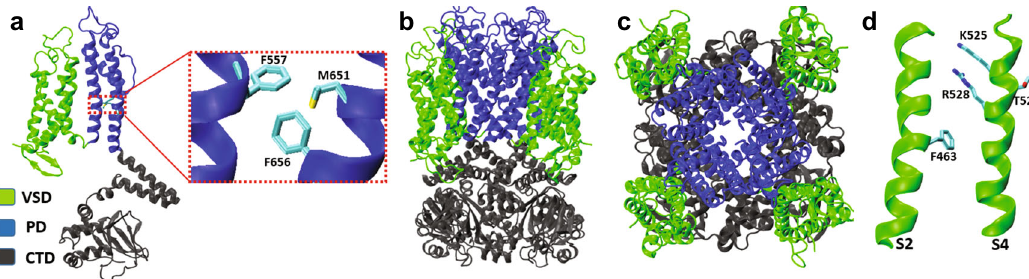
Fig. 1 Structural domains of the open-state hERG1 channel considered in this work (PDBID: 5VA2). a Structural organization of one monomer. The voltage-sensor domain (VSD), the pore domain (PD), and the cytoplasmic domain (CTD) are highlighted in green, blue, and gray cartoons, respectively. The inset displays key residues (licorice representation) of the PD accessible from the VSD – PD interface. The panels b and c show side- and extracellular views, respectively, of the full tetrameric hERG1 structure. Panel d displays the S2 and S4 helices (green cartoons) from one of the VSDs, highlighting key residues (licorice representation) involved in voltage-dependent gating. The C, O, N, and S atoms in a and d are colored in cyan, red, blue, and yellow, respectively.